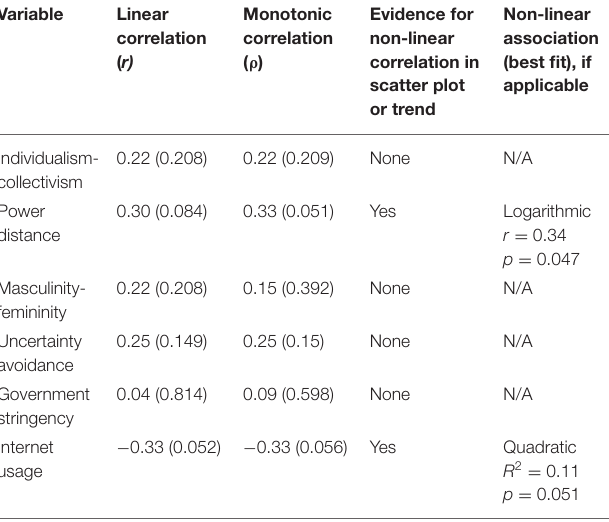
TABLE 2 | Linear and non-linear associations between cultural dimensions, government stringency, internet usage and the estimated prevalence of PTSD symptoms by